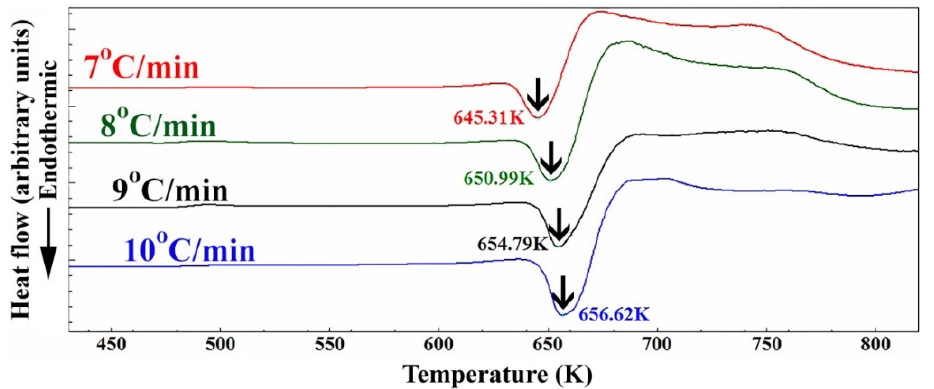
Figure 4. DSC curves achieved at different heating rates (7, 8, 9, and 10 °C/min) of nanocomposite MgH 2 /5.2TiC/4.6FeCr powders obtained after 50 h of milling.